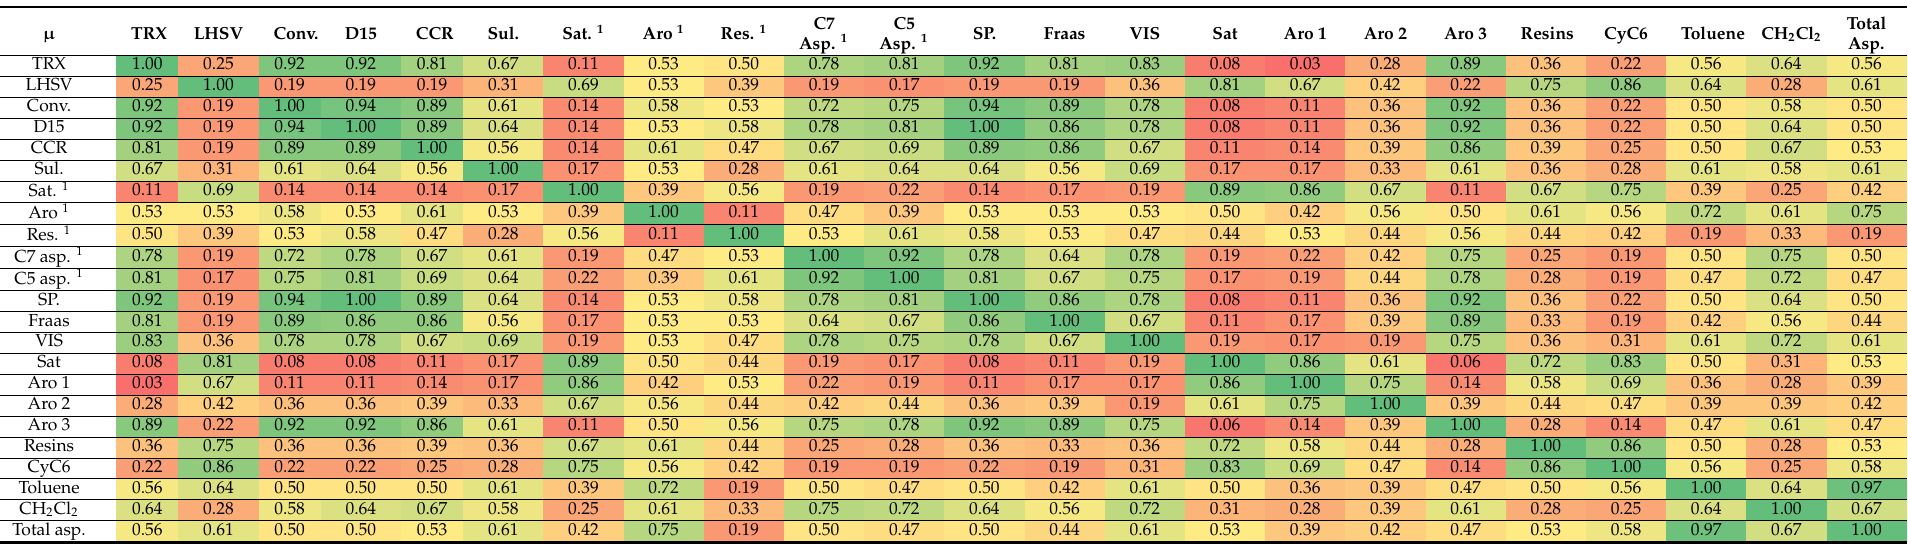
Table 8. µ -Value of the ICrA evaluation of relations between bulk properties, LNB SARA, SAR-AD characteristics of H-Oil VTB, and reaction